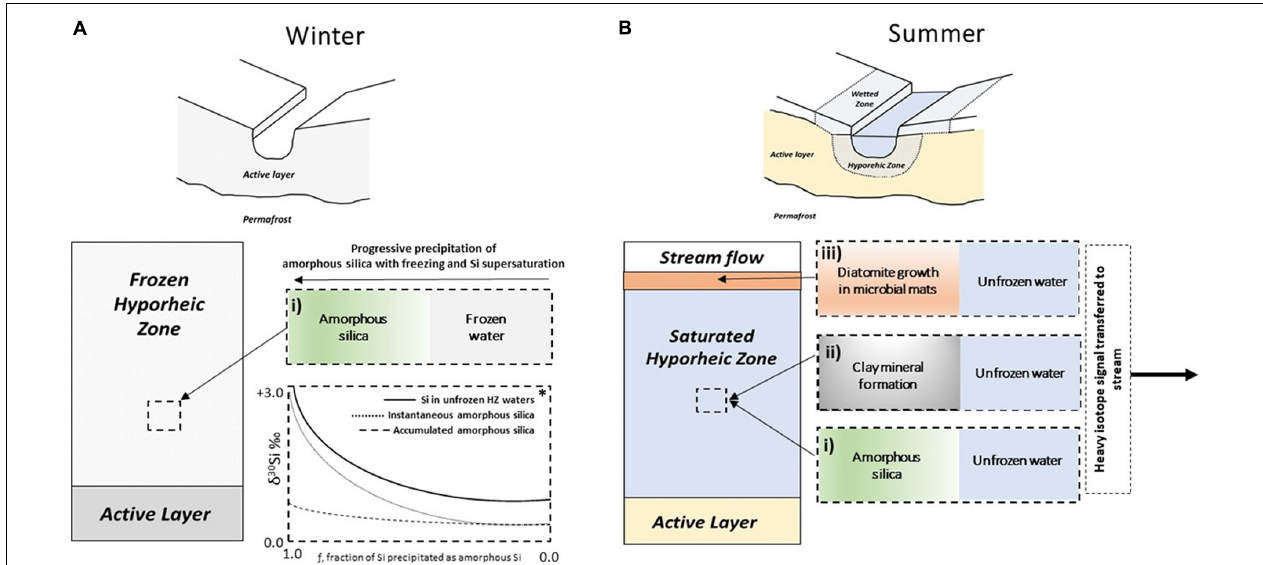
FIGURE 9 | Schematic showing the principal processes controlling dissolved Si isotope compositions in Crescent Stream during the austral winter (A) and summer (B) months. The initial pool of Si(OH) 4 is supplied by primary mineral dissolution (Gooseff et al., 2002) in the hyporheic zone. Si isotope fractionation occurs during subsequent secondary inorganic and biologically mediated Si phases formation. During winter (A) waters in isolated pockets of the hyporheic zone freeze, resulting in supersaturation of Si(OH) 4 and precipitation of amorphous silica (i). Under these conditions, unidirectional kinetic isotope fractionation occurs in accordance with the Rayleigh fractionation model (*) and amorphous silica preferentially incorporates the light isotopes ( 30 ε = –1.0 ), leaving the remaining unfrozen water with relatively high δ 30 Si compositions. With progressive amorphous silica formation, the Si isotope composition of Si(OH) 4 in unfrozen water evolves to heavier values. (cid:104) During summer (B) , ice in the hyporheic zone thaws and the remaining DSi (in equilibrium with amorphous Si) presenting high δ 30 Si DSi compositions is released from the isolated pockets into Crescent Stream. In addition, diatoms are actively forming in microbial mats (ii) in the hyporheic zone during summer months, preferentially taking up light Si isotopes, providing a background contribution of higher δ 30 Si DSi compositions in Crescent Stream. These processes are superimposed onto clay mineral formation (iii), also preferentially taking up light Si isotopes.